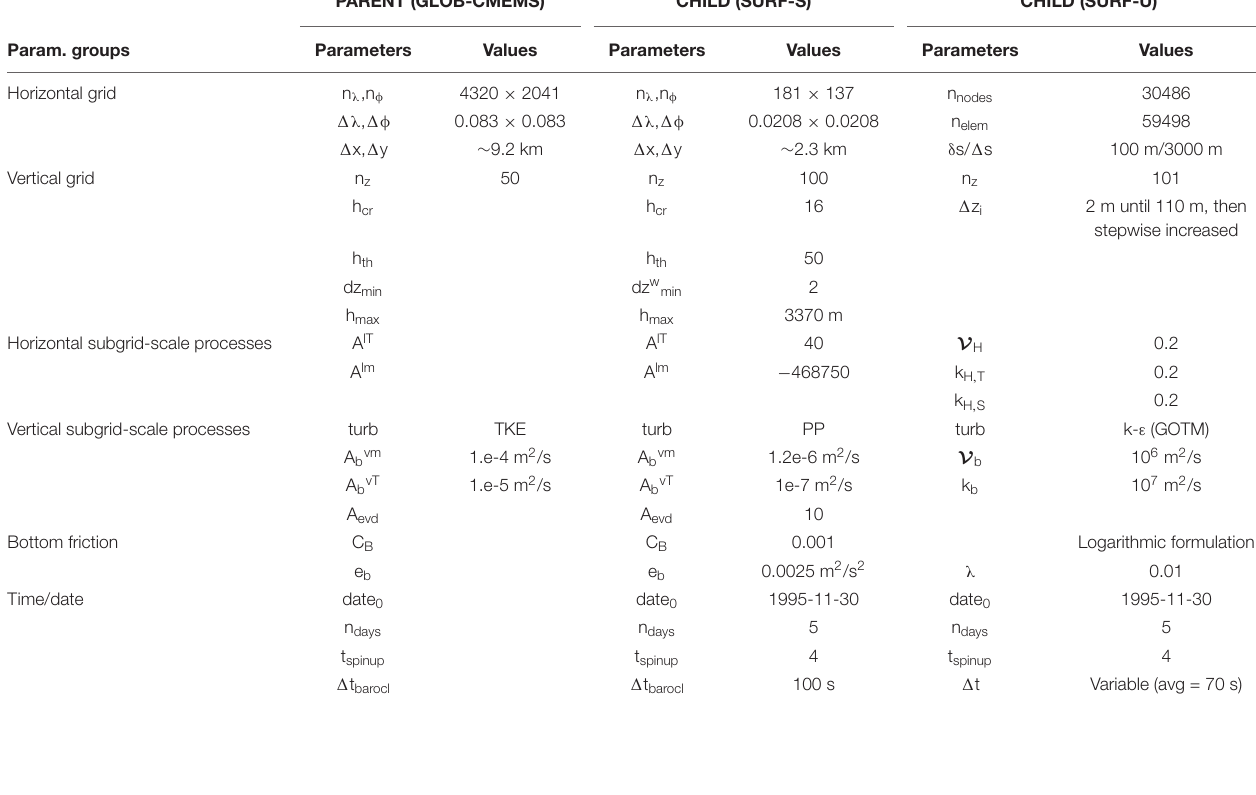
TABLE A6 | Model parameters characterizing the Sunda Strait experiment